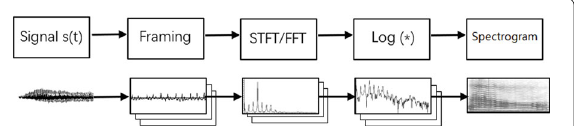
Fig. 4 Multiple order MFCC features of normal and asphyxiated infant cry Fig. 5 The flowchart of spectrogram